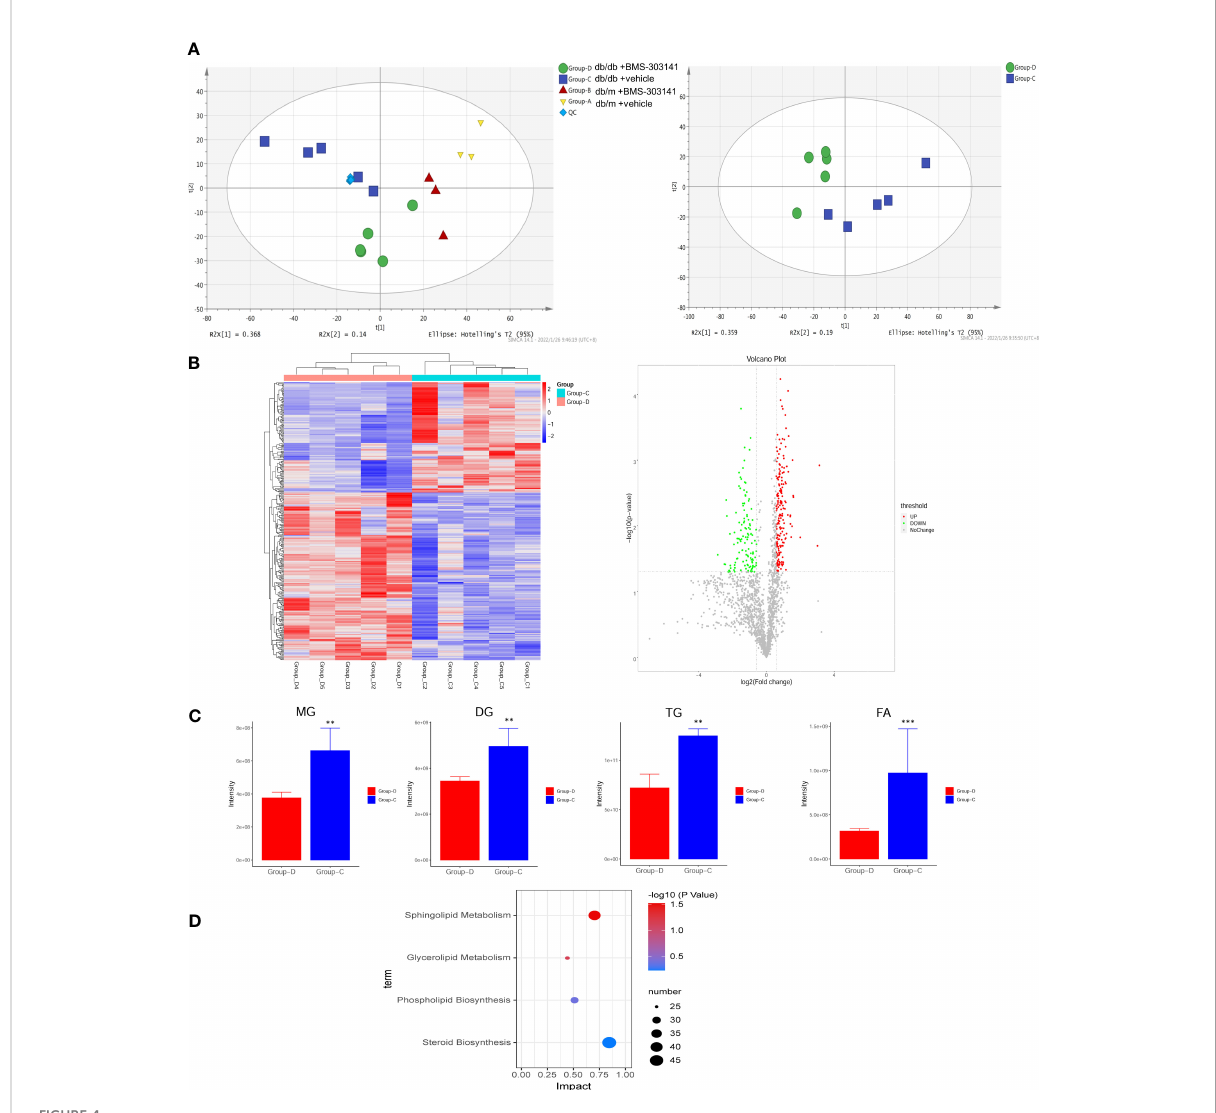
FIGURE 4 BMS-303141 suppresses lipid production with altered lipid pro fi les. (A) PCA analysis of the original four groups and both db/db mouse groups. (B) Heatmap and Volcano plot between two db/db mice groups with fold change. (C) The relative contents of some of the different lipid classes detected in the Group-D vs Group-C comparison. Group (D) KEGG pathway analysis. The mean ± SD of four different tests is represented by each bar. *P < 0.05, **P < 0.01, ***P < 0.001 Group-D vs Group-C, n = 5. ChE, cholesterol ester; DG, diglyceride; MG, monoglyceride; TG, triglyceride; FA, fatty